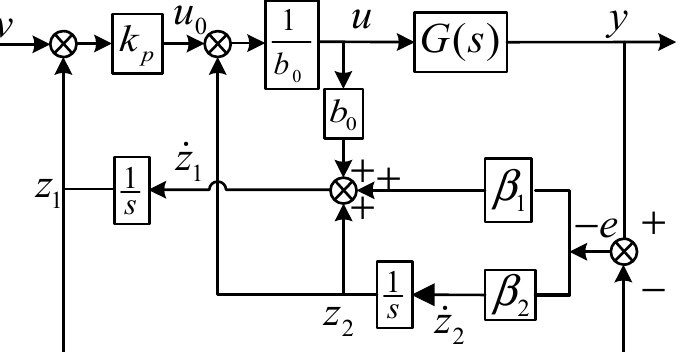
Figure 3. The structure block diagram of the traditional LADRC.